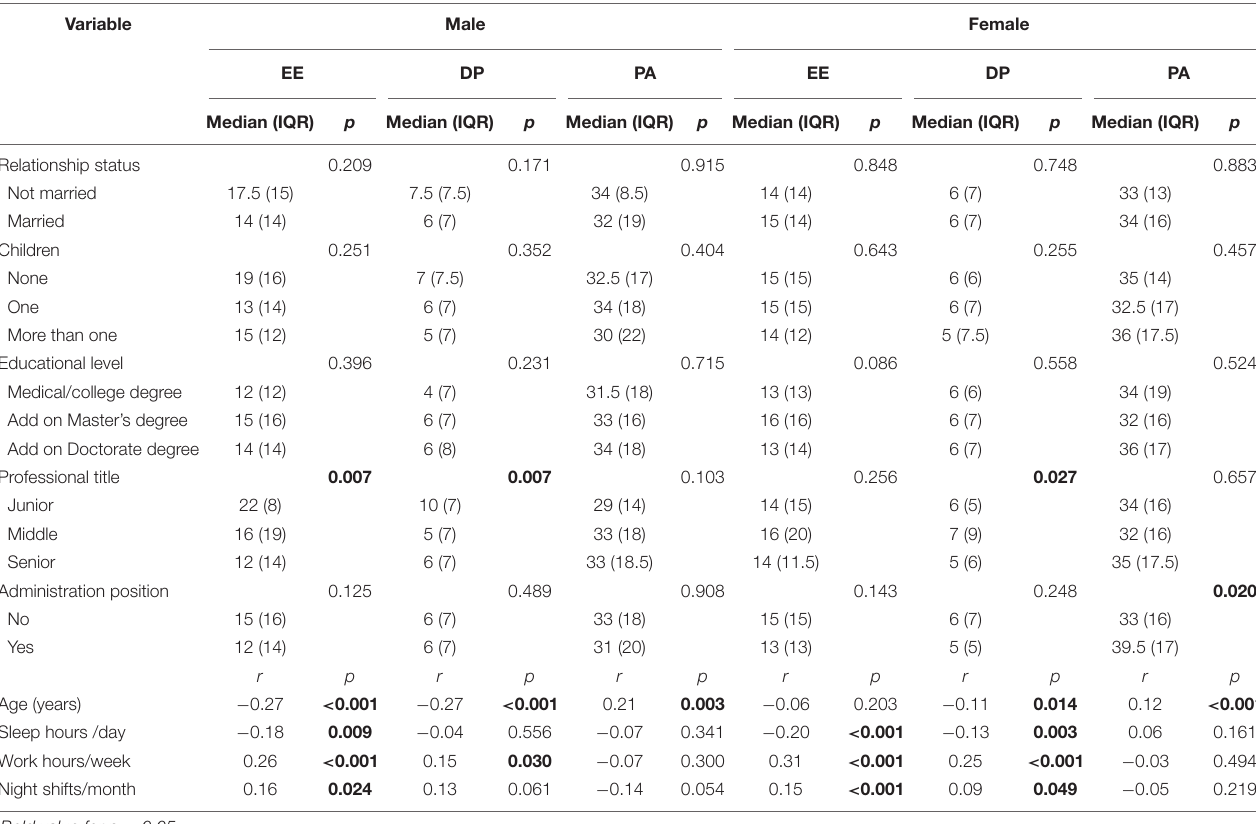
TABLE 3 | Univariate analyses of factors associated with burnout in 711 endocrinologists in China. Variable Male